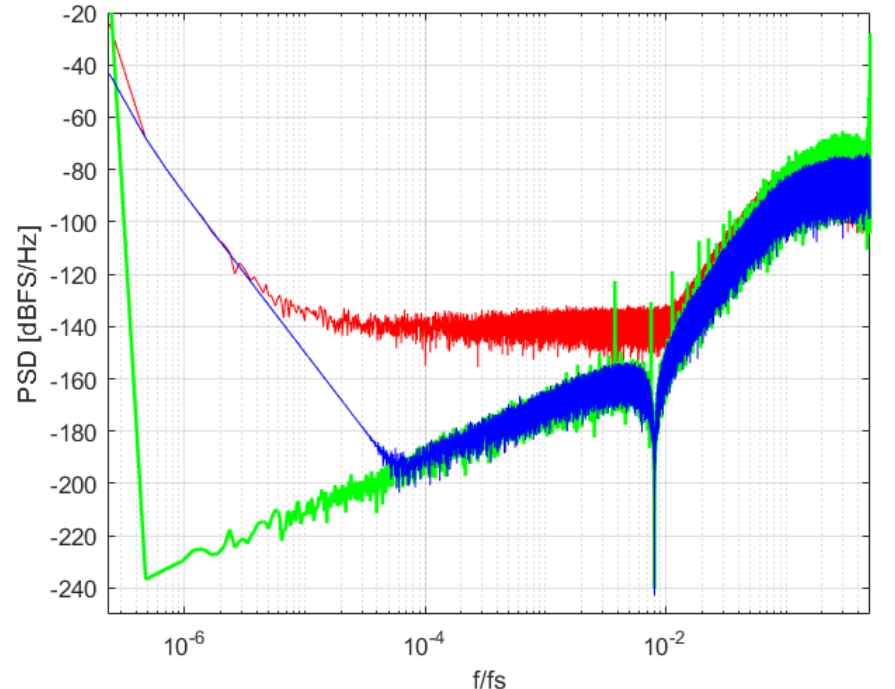
Figure 3. PSD comparison of low IBN power (blue), high IBN power (red), and DC input of 4 kHz (green). 2 24 points (8.73 s) are simulated. Σ∆ M parameters are: third-order, 4-bits, BW = 20 kHz, OSR = 48, OBG =